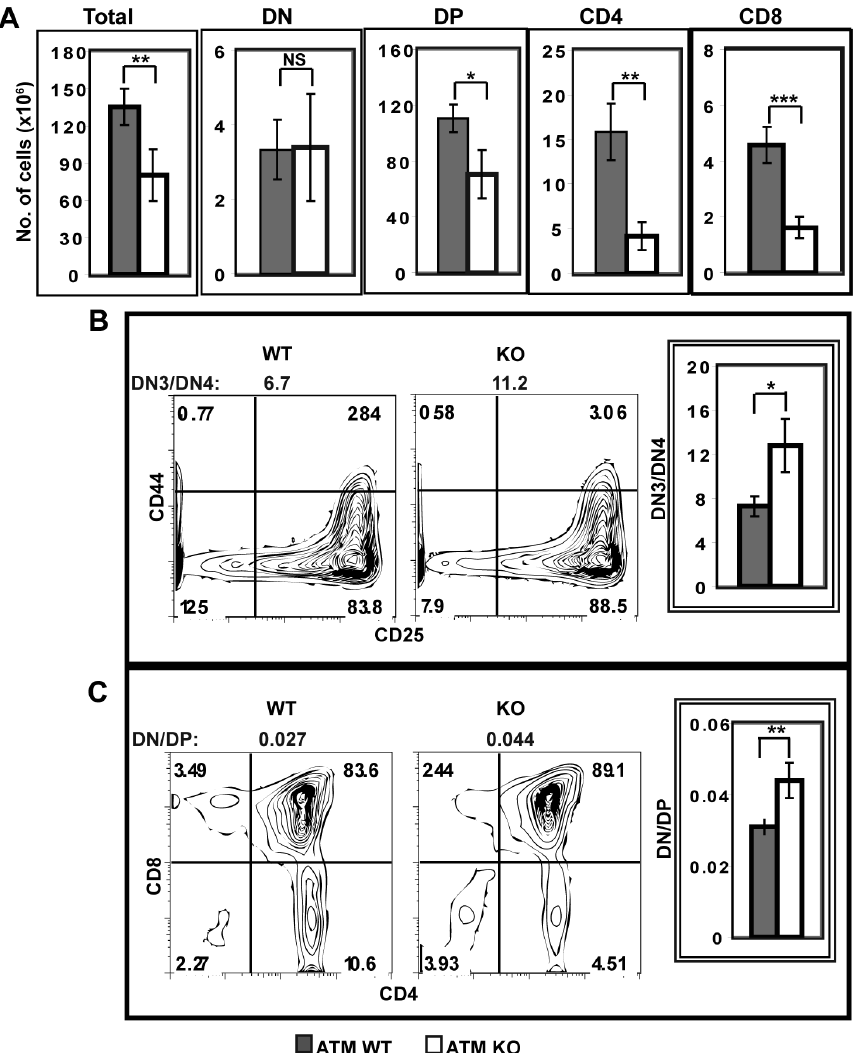
Figure 3. ATM deficiency alters thymic development. (A) Thymocytes from four pairs of ATMWT and KO mice were analyzed by flow cytometry to enumerate cells in each CD4/CD8 subpopulation. (B) The DN3/DN4 ratio is elevated in ATMKO thymi. Representative CD44 and CD25 staining profiles of lineage negative ATMWT and KO DN cells and the calculated DN3/DN4 ratios are shown. Quantification of DN3/DN4 ratios measured in ATMWT and KO thymi (ATMWT vs KO p , 0.025). (C) The DN/DP ratio is elevated in ATMKO thymi. Images show CD4/CD8 staining profiles and corresponding DN/DP ratios from representative ATMWT and KO thymi. Quantification of DN/DP ratios measured in ATMWT and KO thymi (ATMWT vs KO p , 0.003). Data are mean ( 6 SEM) of six separate experiments analyzing nine pairs of ATMWT and KO thymi. P values were calculated using Student’s paired 1-tailed t test.